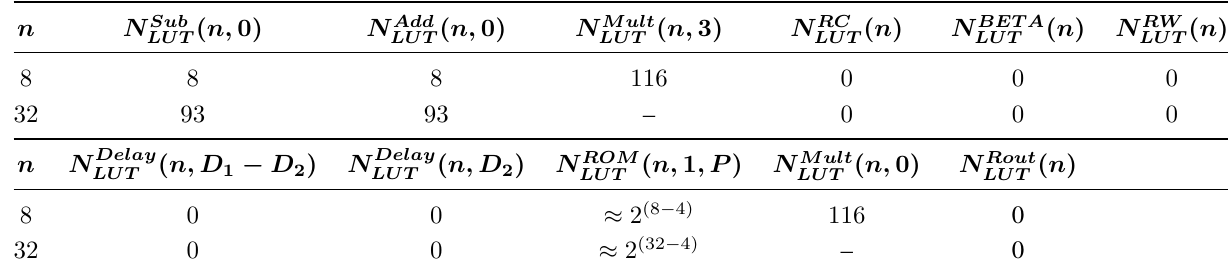
Table 7. Estimated number of LUTs provided by the Xilinx manufacturer [29–33].